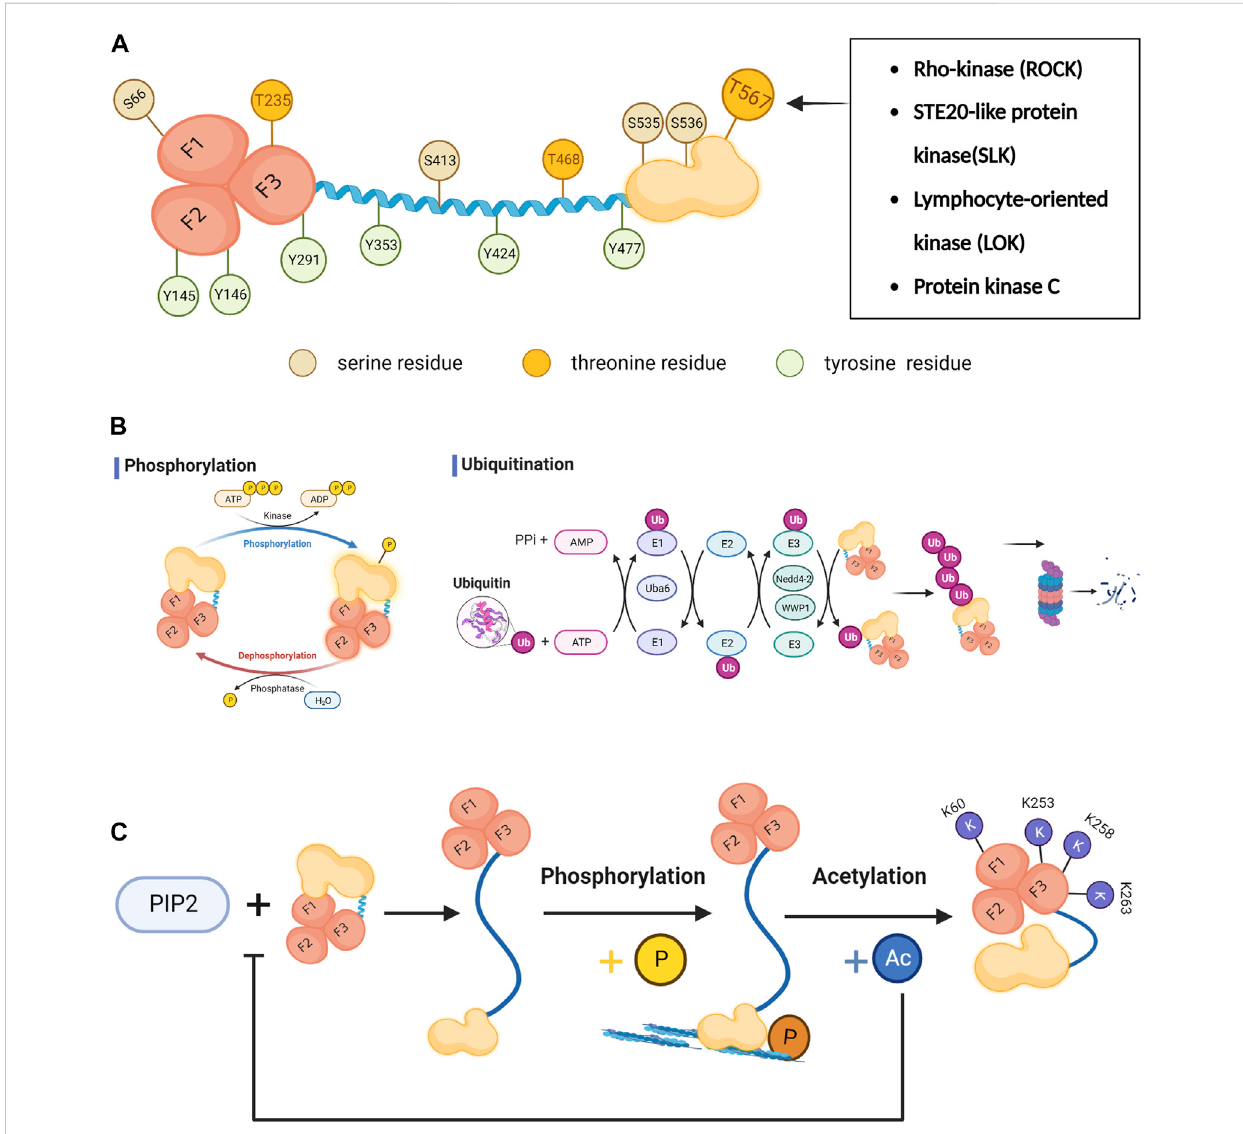
The post-translational modi fi cations of ezrin. (A) The active state of ezrin protein and the phosphorylation sites:T567, S535 and S536 are located at theC-ERMADterminus,ofwhichT567isthemoststudiedphosphorylationsite;Y477islocatedintheLinkerregion;Y424,Y353,S413,T468existinthe α - helical domain; N-ERMAD terminus contains S66(F1), Y145(F2), Y146(F2), T235(F3), Y291(F3). Among them, T235, T468 and T567 are threonine residues. S66,S413, S535 and S536 are serine residues. Y145, Y146, Y291,Y353, Y424 and Y477 are tyrosine residues. The critical T567 on C-ERMAD could be phosphorylated by Rho-kinase (ROCK), STE20-like protein kinase (SLK), lymphocyte-oriented kinase (LOK)and protein kinase C(PKC). (B) The phosphorylation and ubiquitination process of ezrin:Protein ubiquitination is mediated sequentially by ubiquitin-activating enzyme E1, ubiquitin-binding enzyme E2, and ubiquitin-ligase E3. The ubiquitin-activating enzyme E1 includes UBA1 and UBA6. (C) Acetylated lysine sites exist in the FERM structural domain of ezrin (K60, K253, K258 and K263). Ezrin acetylation prevents Thr567 phosphorylation. Acetylated ezrin can lead to the translocation of ezrin fromthecellmembranetothecytoplasmbyaffectingtheaf fi nityofitsC-ERAMtoF-actin,reducingthebindingoftheN-FERMstructuraldomaintoPIP2, membrane-associated proteins and cell adhesion molecule.